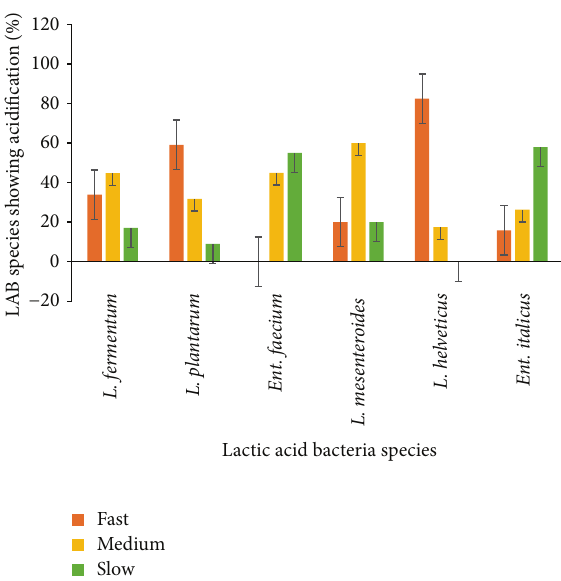
Figure 1: Acidification properties of predominant LAB species isolated from Nunu : fast, medium, and slow, when a pH of 0.4U was achieved after 3h, 6h, and 24 h,